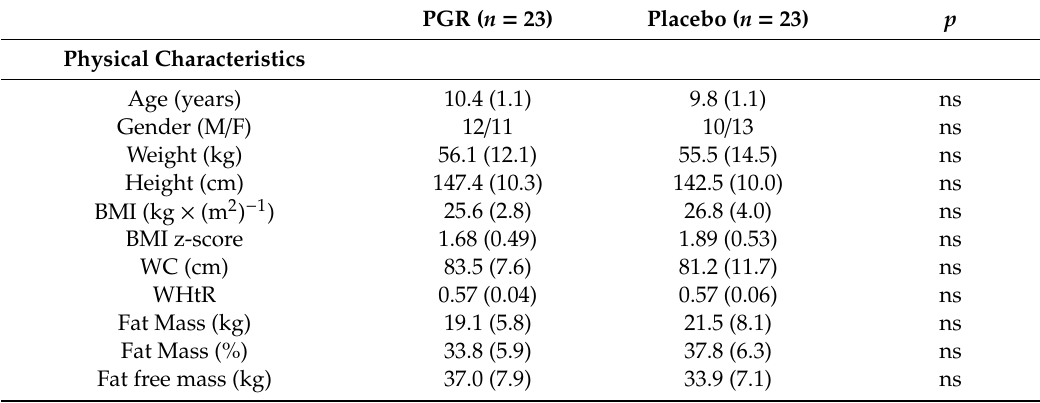
Table 1. Physical characteristics of the subjects and energy and macronutrient composition of the test